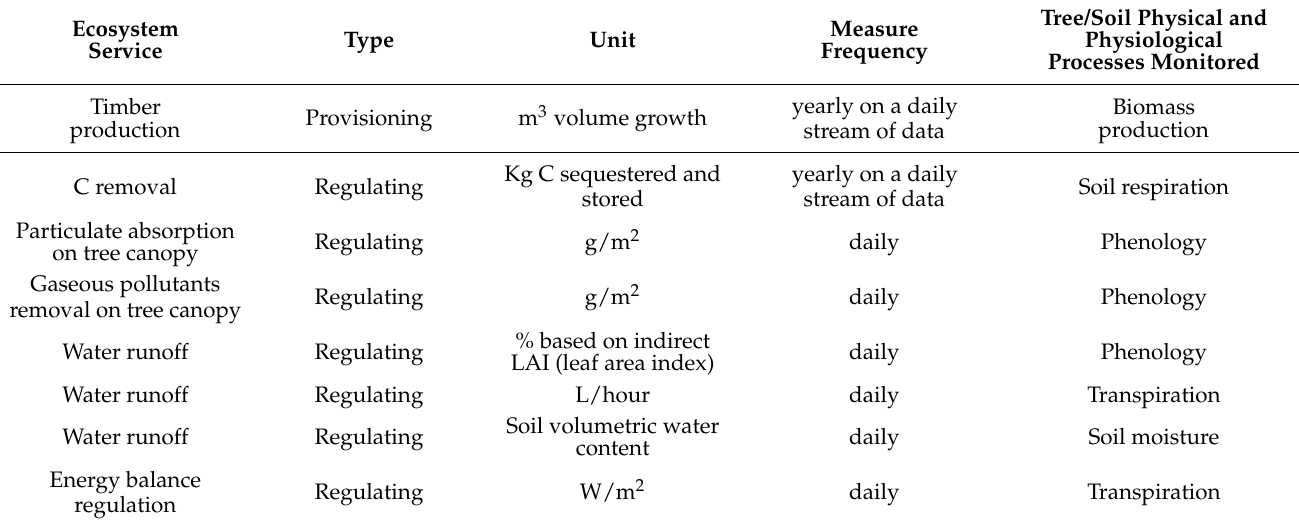
Table 3. Ecosystem services evaluation at tree level based on continuous monitoring of the physical and physiological